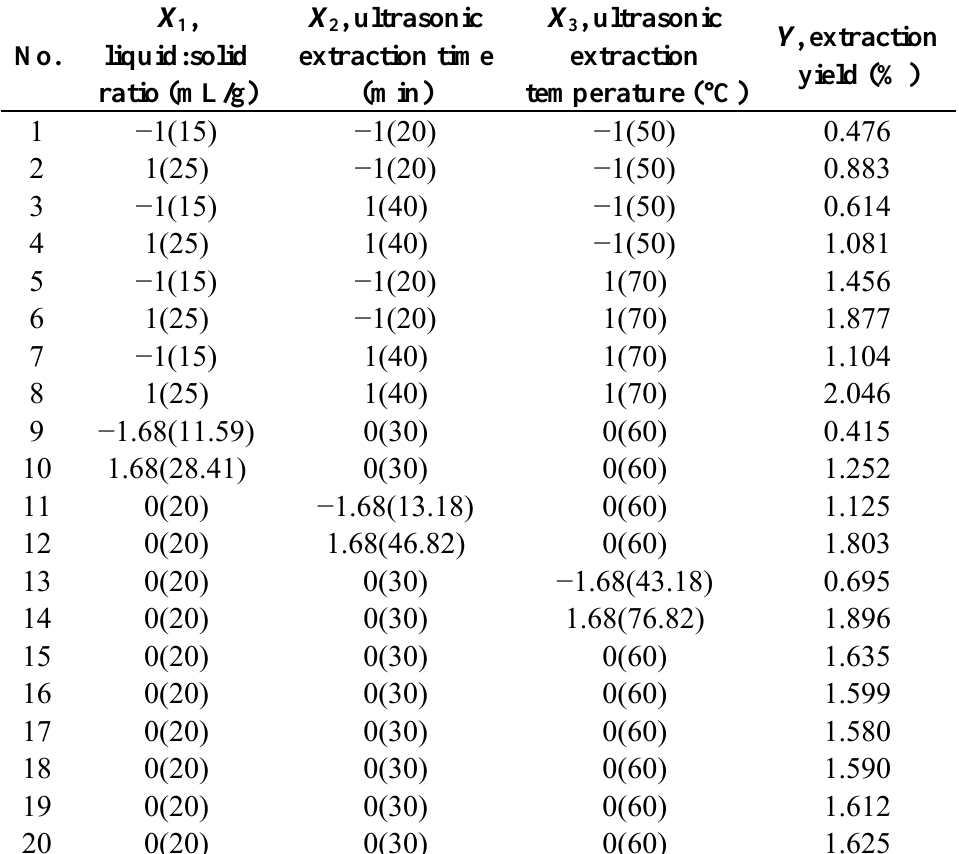
Table 1. Response surface central composite design and results for ellagic acid extraction yield.